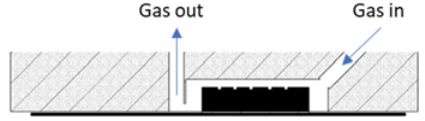
Figure 5. Measurement chamber (left) and Grove’s 42 × 24 mm four ‐ channel gas sensor module (right).